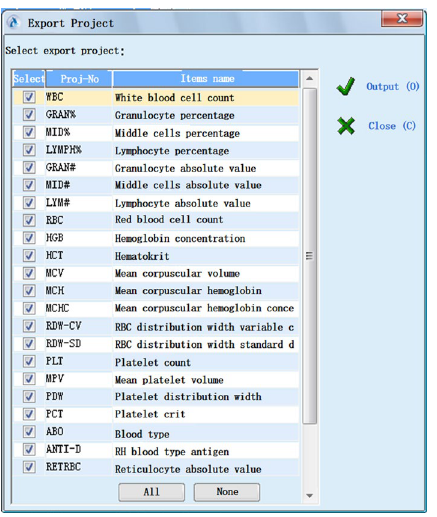
Fig. 5 Sample programming capabilities Fig. 6 System query